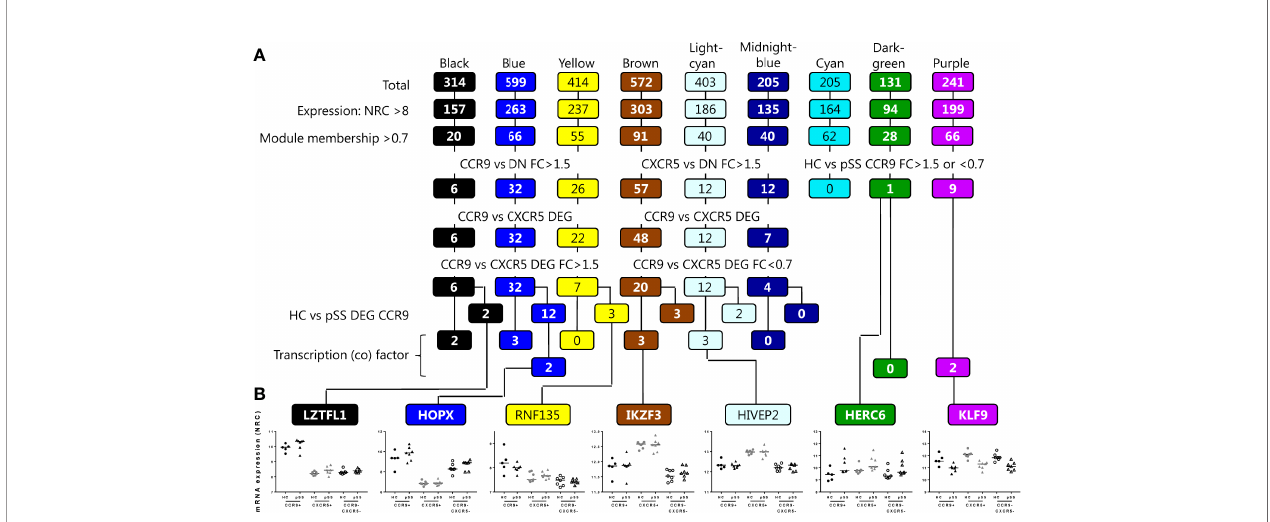
FIGURE 3 | Work fl ow for selection of target genes for validation per module. Genes from the modules are selected based on the criteria shown, including expression level (normalized read counts >8), module membership >0.7, differential expression between the Th cell subsets with a fold change of >1.5, or between HC and pSS of >1.5 or <0.7, and fi nally transcription (co) factors are selected. From the lower 4 rows, target genes that are also supported by literature evidence are selected for further analysis (A) . Representative examples of genes selected based on the criteria and per module are shown (B)